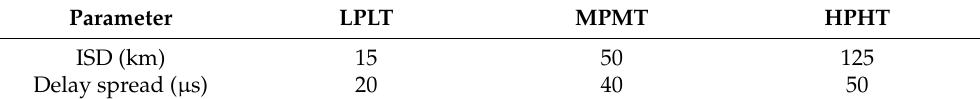
Table 1. Correspondence between maximum delay spread and intersite distance for modeling SFNs.